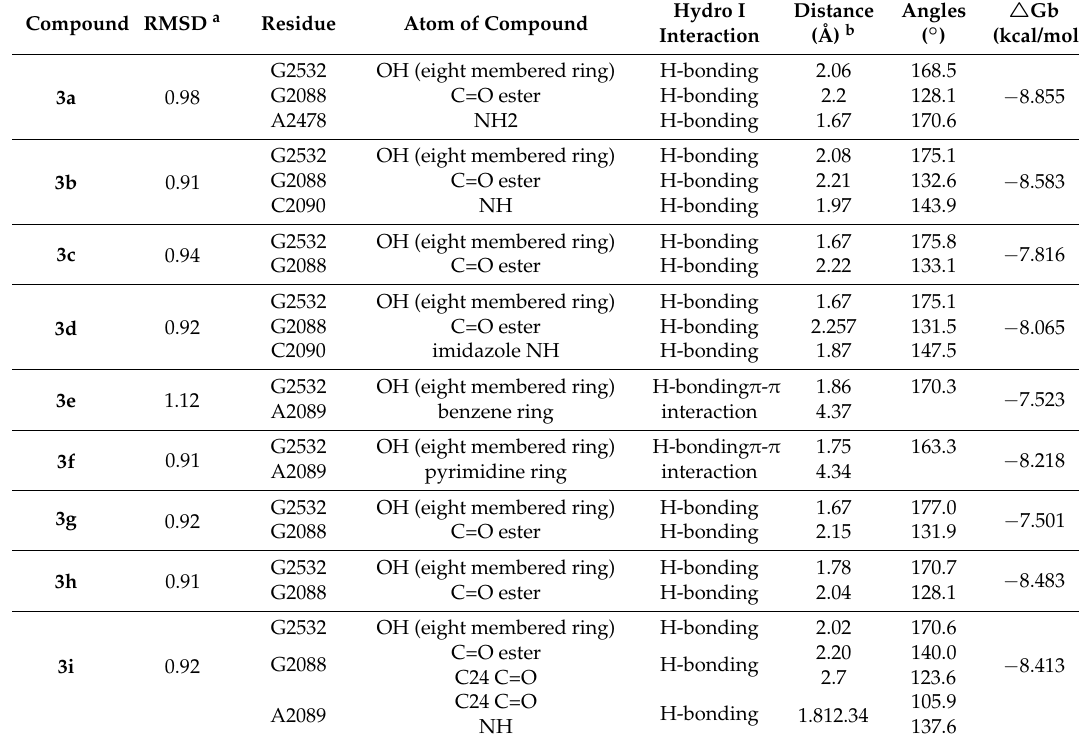
Table 2. Binding RMSD (Root-mean-square Deviation), number of noncovalent molecular interactions and free energy.